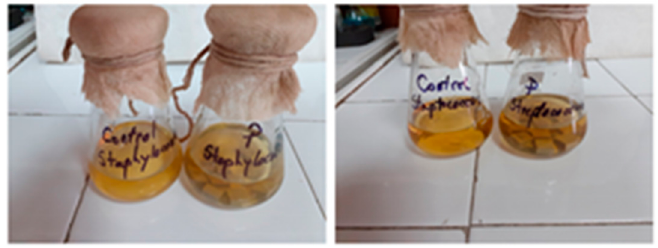
Figure 4. Submerged cultivation of bacterial strains.